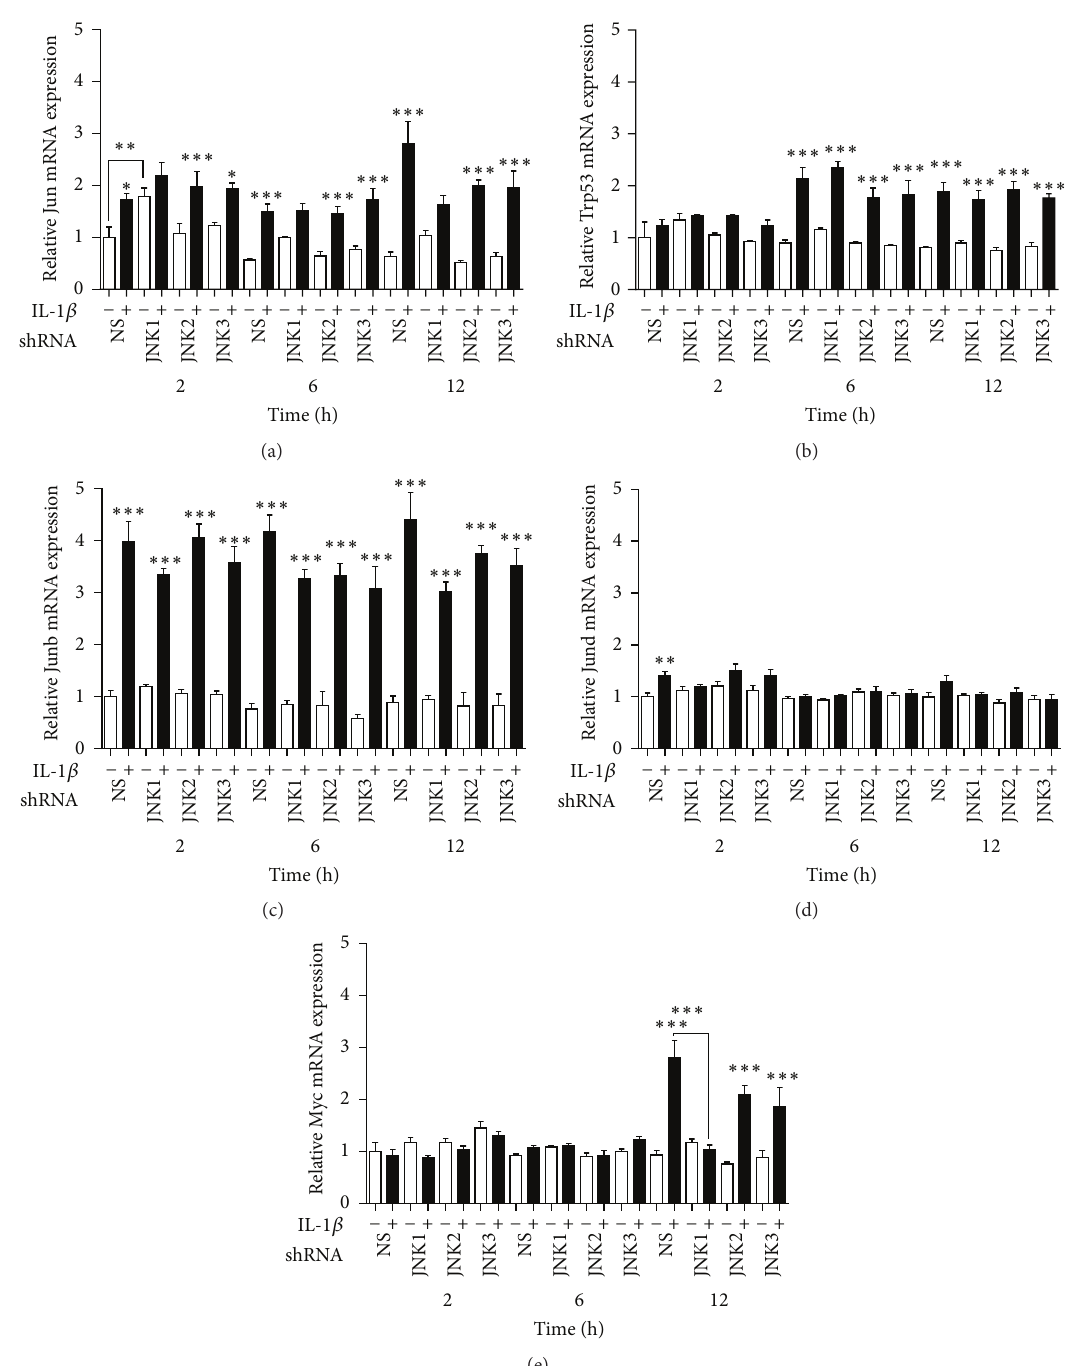
Figure 5: JNK1 knockdown attenuates the regulation of Myc mRNA expression by IL-1 𝛽 . Stable INS-1 cell lines expressing shRNA for JNK1, JNK2, JNK3, nonsense shRNA, or empty vector controls were exposed to 150 pg/mL IL-1 𝛽 (closed bars) or vehicle (open bars) for 2, 6, and 12h. Relative mRNA expression were measured using quantitative RT-PCR and normalized to the average of 18S and Hprt1. (a) Relative Jun mRNA expression, (b) relative Trp53 mRNA expression, (c) relative Junb mRNA expression, (d) relative Jund mRNA expression, and (e) relative Myc mRNA expression. Data are shown as means ± SEM of 3–5 independent experiments. ∗ 𝑃 < 0.05 , ∗∗ 𝑃 < 0.01 , and ∗∗∗ 𝑃 < 0.001 , comparing expression in the presence with expression in the absence of IL-1 𝛽 , unless otherwise